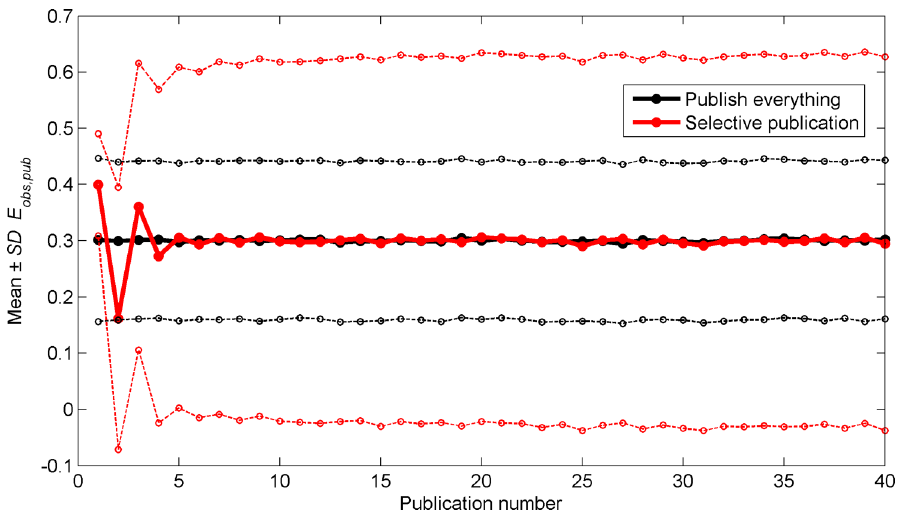
Figure 2. Mean (thicker solid lines) and mean plus/minus one standard deviation (thinner dashed lines) of observed effects of individual studies ( E obs,pub ) as a function of the number of publications. The means and standard deviations are calculated across the 5,000 repetitions of the simulation.